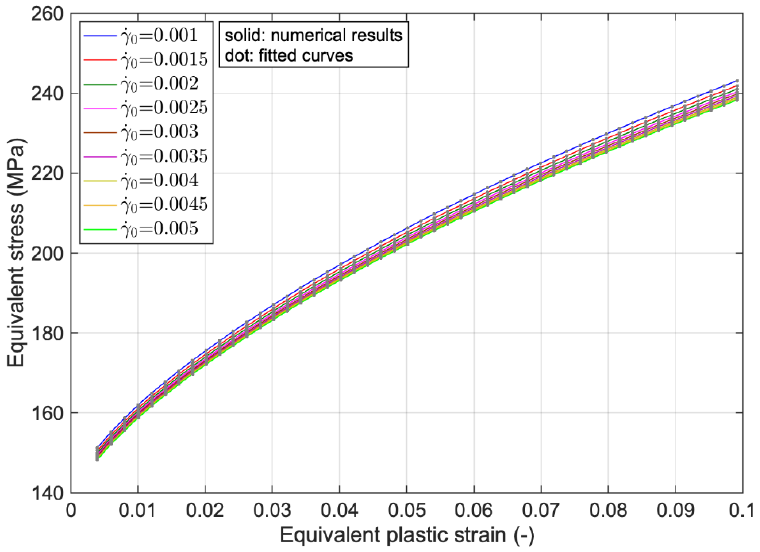
. γ . Figure 11. Comparison between numerical results and fitted curves with change in 0 0